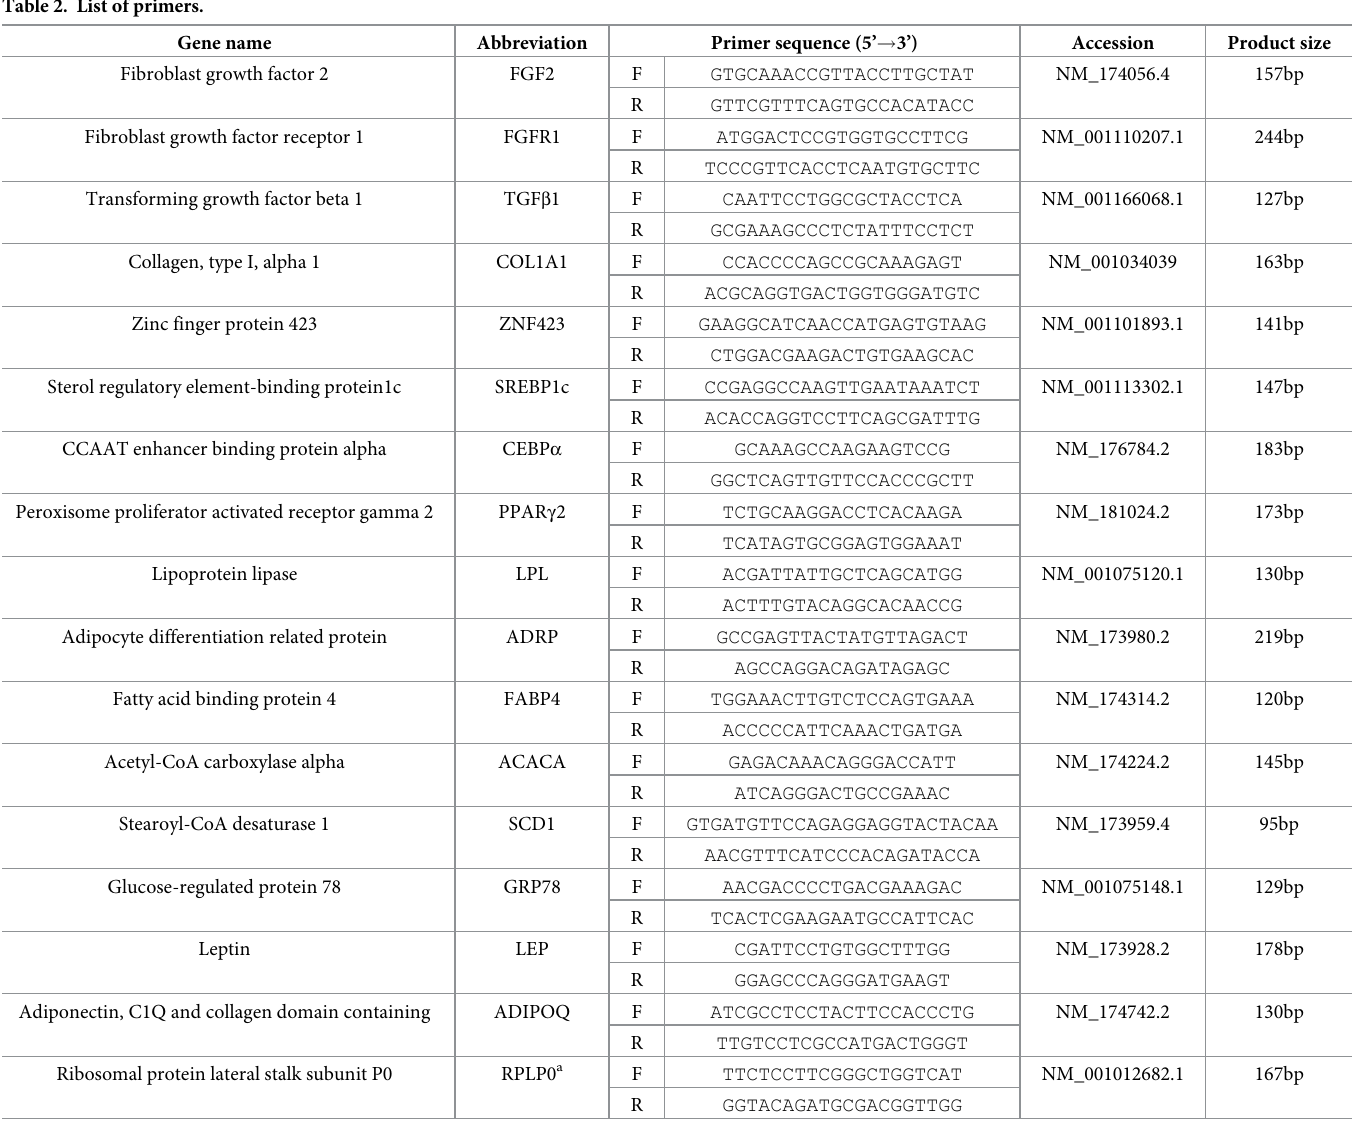
Table 2. List of primers.